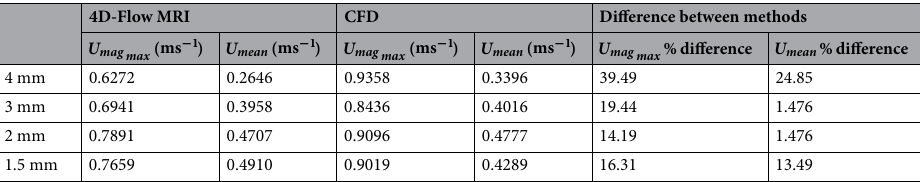
1 Table 6. Velocity magnitude ( ms − ) data at the mid-ascending aortic plane during systole calculated using 4D-Flow MRI data and CFD data, including a comparison between the two methods for each spatial resolution.